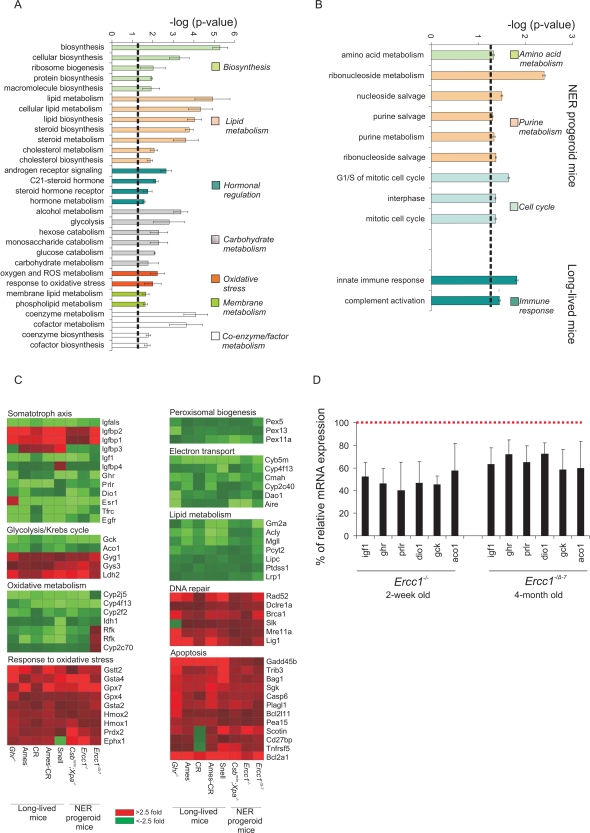
Significantly over-represented biological processes in NER progeria, dwarfism and CR.(A) Shared and (B) distinct biological processes associated with NER progeria, dwarfism and CR. All significant differentially transcribed genes derived from each mouse group (Csbm/m;Xpa−/−, Ercc1−/− and Ercc1−/Δ−7, Ghr
−/−, Ames, Ames-CR and Snell) against their corresponding controls (Figure S1A) were grouped into functional GO categories and tested for overrepresentation. Among others, lipid and carbohydrate metabolism, hormonal regulation and a response to oxidative stress were significantly over-represented in both progeroid and long-lived mouse groups. Amino acid metabolism, purine metabolism and cell cycle were only identified in NER progeria, whereas immune responses were limited only to long-lived mice. (C) Expression of genes associated with over-represented biological processes. The average gene expression (upregulation in red; downregulation in green) in each of the mouse groups (X-axis) is compared to that of the corresponding wt controls. (D) Quantitative real time PCR evaluation of % of relative mRNA expression levels of genes associated with the GH/IGF1 somatotropic axis (Igf1, Ghr, Prlr, dio1) and carbohydrate metabolism (gck, aco1) in 15-day old Ercc1−/− and 16-week old Ercc1−/Δ−7 mice as compared to corresponding age matched wt controls. For each biological process, p-values represent the average of p-values obtained for each over-represented process that exceeded the significance threshold (−log (p-value)>1.3) when each progeroid and long-lived mouse group was compared relative to its respective wt control group (error bar = SD).